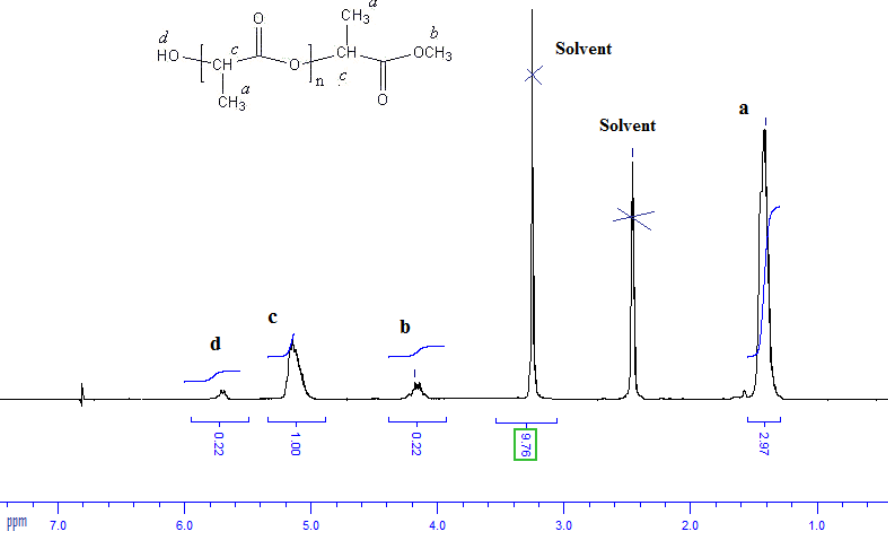
Figure 3. 1 H NMR spectrum of poly (D,L-Lactide) in DMSO-d6